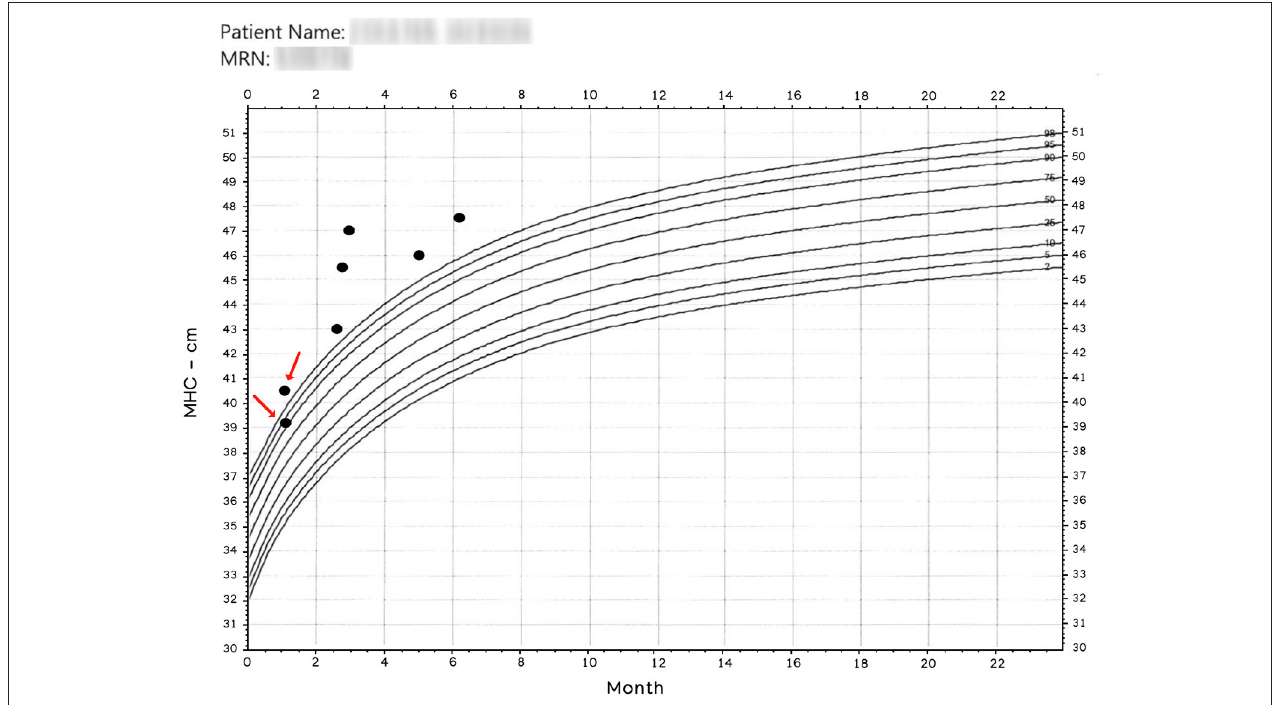
FIGURE 1 | Manually obtained MHC. The x-axis represents age. The entries pointed by arrows were read the same day. Observe that operators have more than 1 cm discrepancy in their readings; nonetheless, a patient classified in and out of normal boundaries is more disturbing. Patient name and MRN have been intentionally